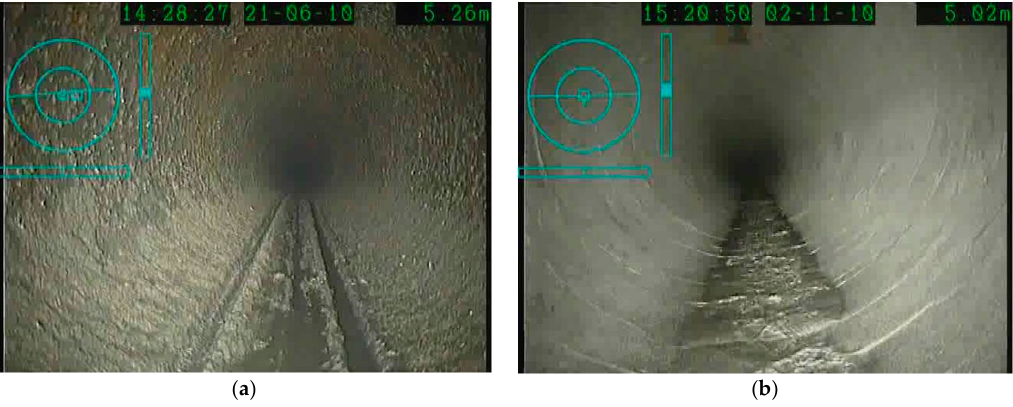
Figure 33. Photos inside the pipe to show the flushing effect in this case study: ( a ) before flushing; and ( b ) after flushing.